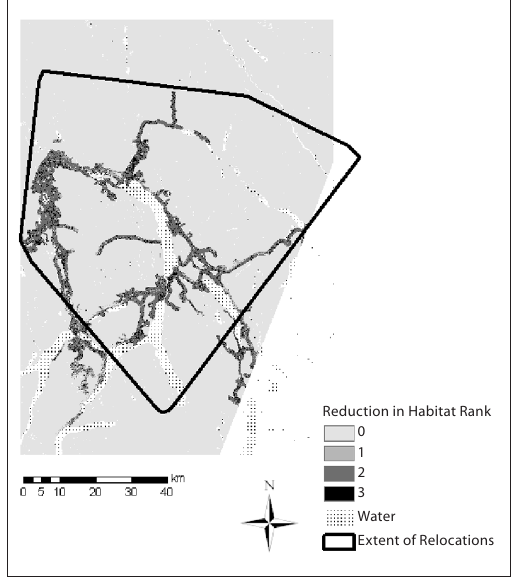
Fig. 4b. Reduction in winter caribou habitat ranking when the ZOI was included on the landscape in the Southern Lakes region of the Yukon Territory, Canada. The solid line is a 100% minimum con- vex polygon of all winter GPS relocations col- lected during the